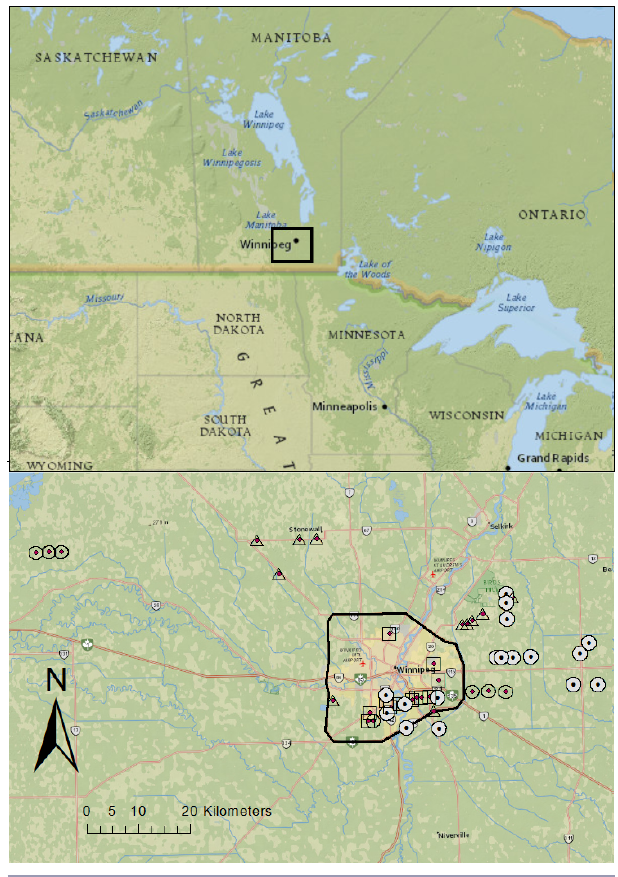
Fig. 1. Map of the study area in Manitoba, Canada (top) centered on the city of Winnipeg (bottom). Hollow squares = sites mowed (without haying) twice per year, hollow triangles = sites mowed (without haying) once per year, hollow circles = sites hayed once per year, opaque circles = sites normally left unmowed and unmanaged except for tree removal. Sites within Winnipeg’s Perimeter Highway (black outline) had more built- up lands within 100 m of transects. Sites northeast of the Perimeter Highway had more wooded lands within 100 m of transects. Sites south, southeast, and west of the Perimeter Highway had more grassland within 100 m of transects.